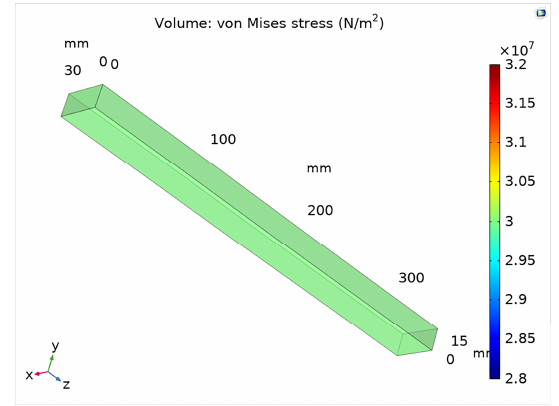
Figure 6. The simulation result of volume stress in the specimen during the compressive stress state (30 MPa).